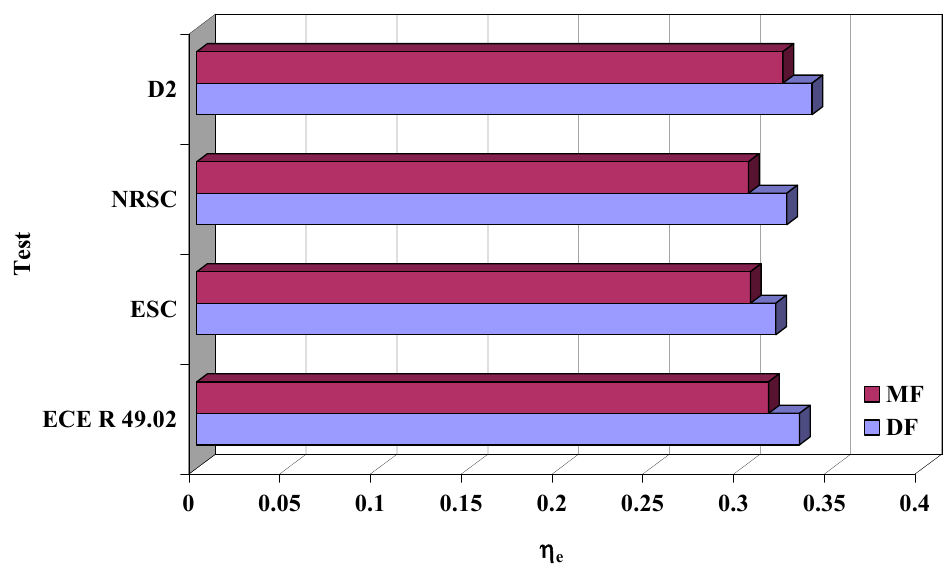
Figure 6. General efficiency in a self-ignition Cummins 6C 8.3 engine running on diesel fuel (DF),